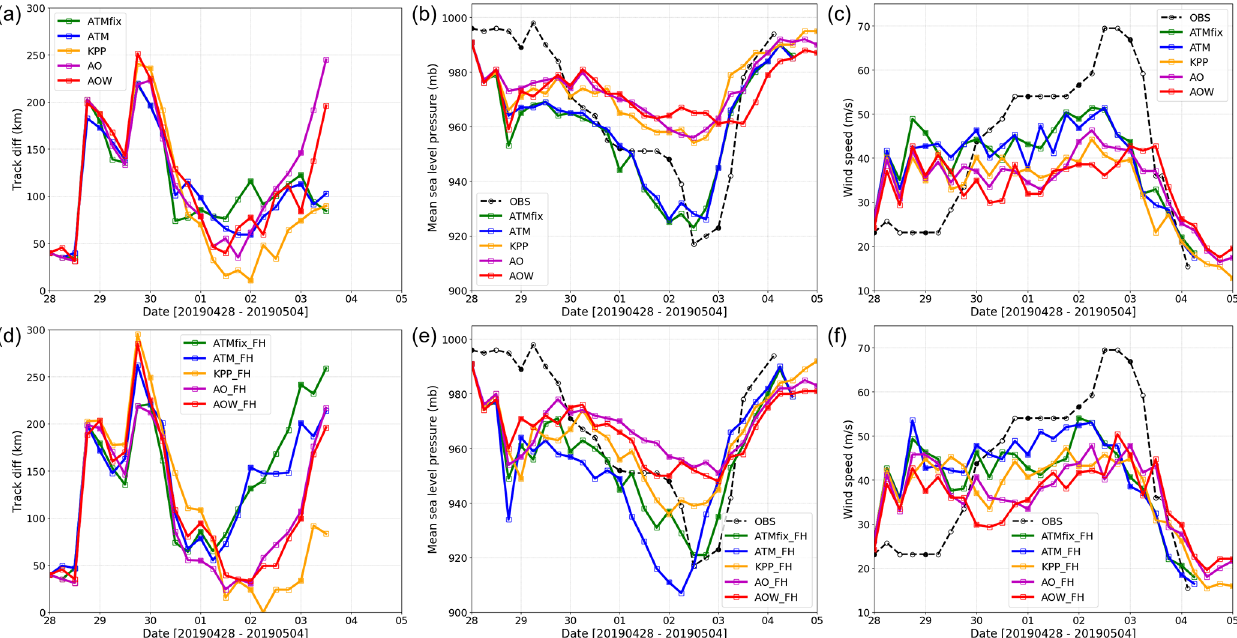
Figure 8. Comparison of observed and simulated cyclone track statistics for all simulations of cyclone Fani. Panels (a) – (c) show results without and (d) – (f) with frictional heating represented. Panels (a) and (d) show difference between coincident simulated and observed track position, (b) and (e) show mean sea level pressure at diagnosed track centre, and (c) and (f) show along-track maximum wind speed. Observed track data are taken from the SXXT50 bulletin based on satellite data